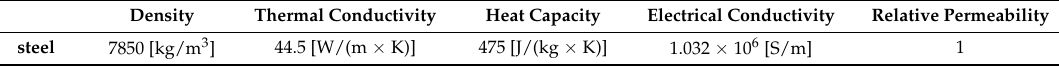
Figure 3. Simulation model for ECPT: ( a ) 3D model and ( b ) steel model. Table 1. Properties of